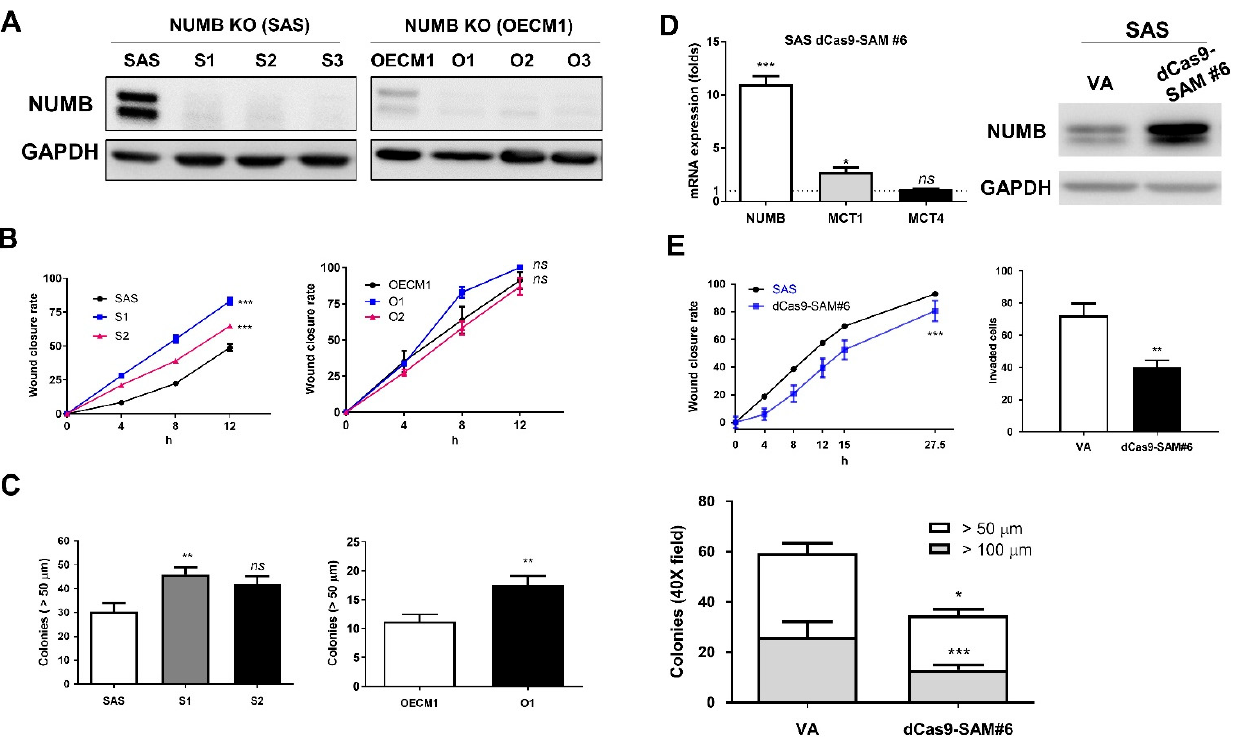
Figure 2. NUMB deletion increases the OSCC oncogenicity. ( A ) Western blot analysis to detect the near absence of NUMB signals in the S1–S3 subclones of SAS cells and O1–O3 subclones of OECM1 cells compared to parental cells. ( B ) Wound healing assay. There was a conspicuous increase in wound closure in the S1 and S2 subclones but no changes in the O1 and O2 subclones. ( C ) Anchorage-independent colony formation. It shows the increased colony formation in S1, S2, and O1 subclones relative to controls. ( D ) The induction of endogenous NUMB expression using the NUMB dCas9-SAM system in SAS cells. The delivery of sgRNA#6 to transactivate the NUMB promoter increased NUMB mRNA (left panel) and protein (right panel) expression. ( E ) Elevated NUMB expression from the endogenous locus decreased the wound closure rate (upper left panel), invasion (upper right panel), and colony formation (lower panel) of SAS cells. VA, vector alone. ns , not significant; *, p < 0.05; **, p < 0.01; ***, p < 0.001.